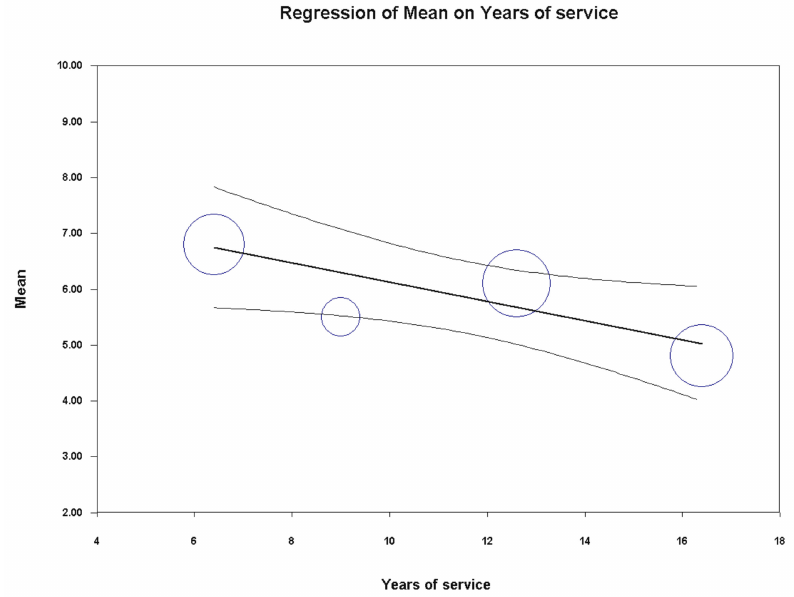
Figure 9. Meta-regression analysis showing a statistically significant association between the pooled PSQI global score in police officers and years of service.